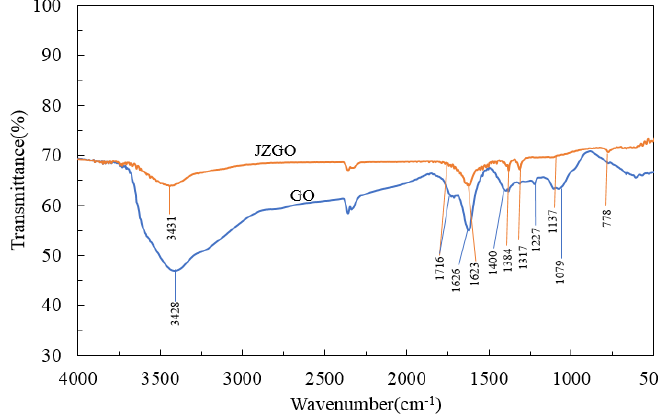
Figure 5. Infrared spectra of graphene oxide (GO) and active graphene (JZGO).